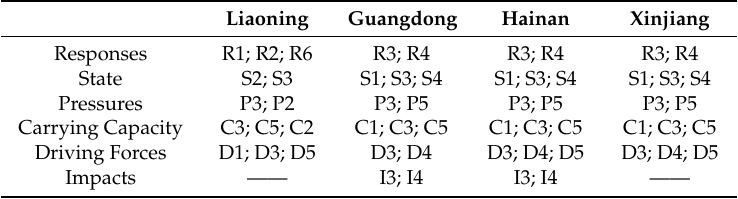
Table A3. The key indicators affecting the marginal growth rate of four provinces.